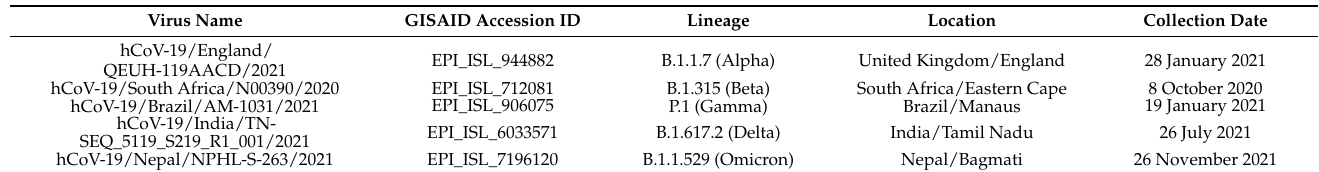
Table 1. SARS-CoV-2 sample genome sequences selected as representative lineage